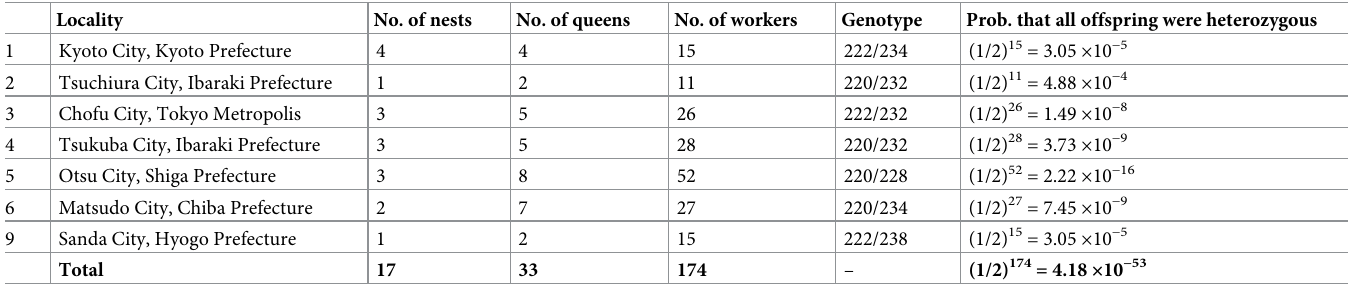
Table 5. Microsatellite analysis